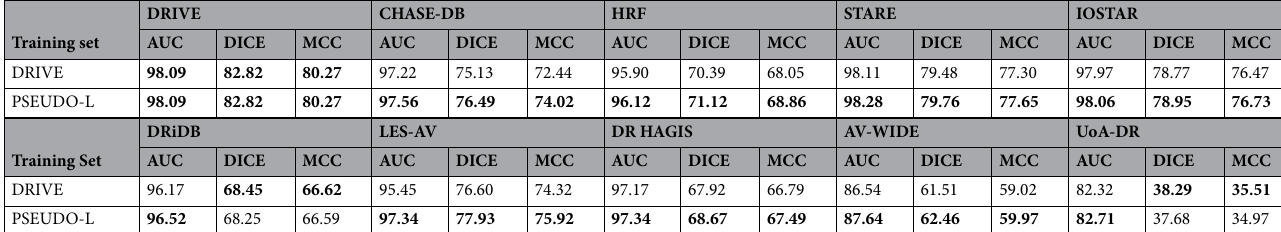
Table 4. Our domain adaptation strategy improves results in a wide range of external test sets. First row: W-Net trained on DRIVE, second row (Pseudo-Labels): same model fine-tuned using the strategy illustrated in Fig. 3. Best metric marked in bold. Please note that Dice/MCC are computed in all cases from segmentations binarized using a threshold that is optimal for maximizing the Dice score in the training dataset (DRIVE).